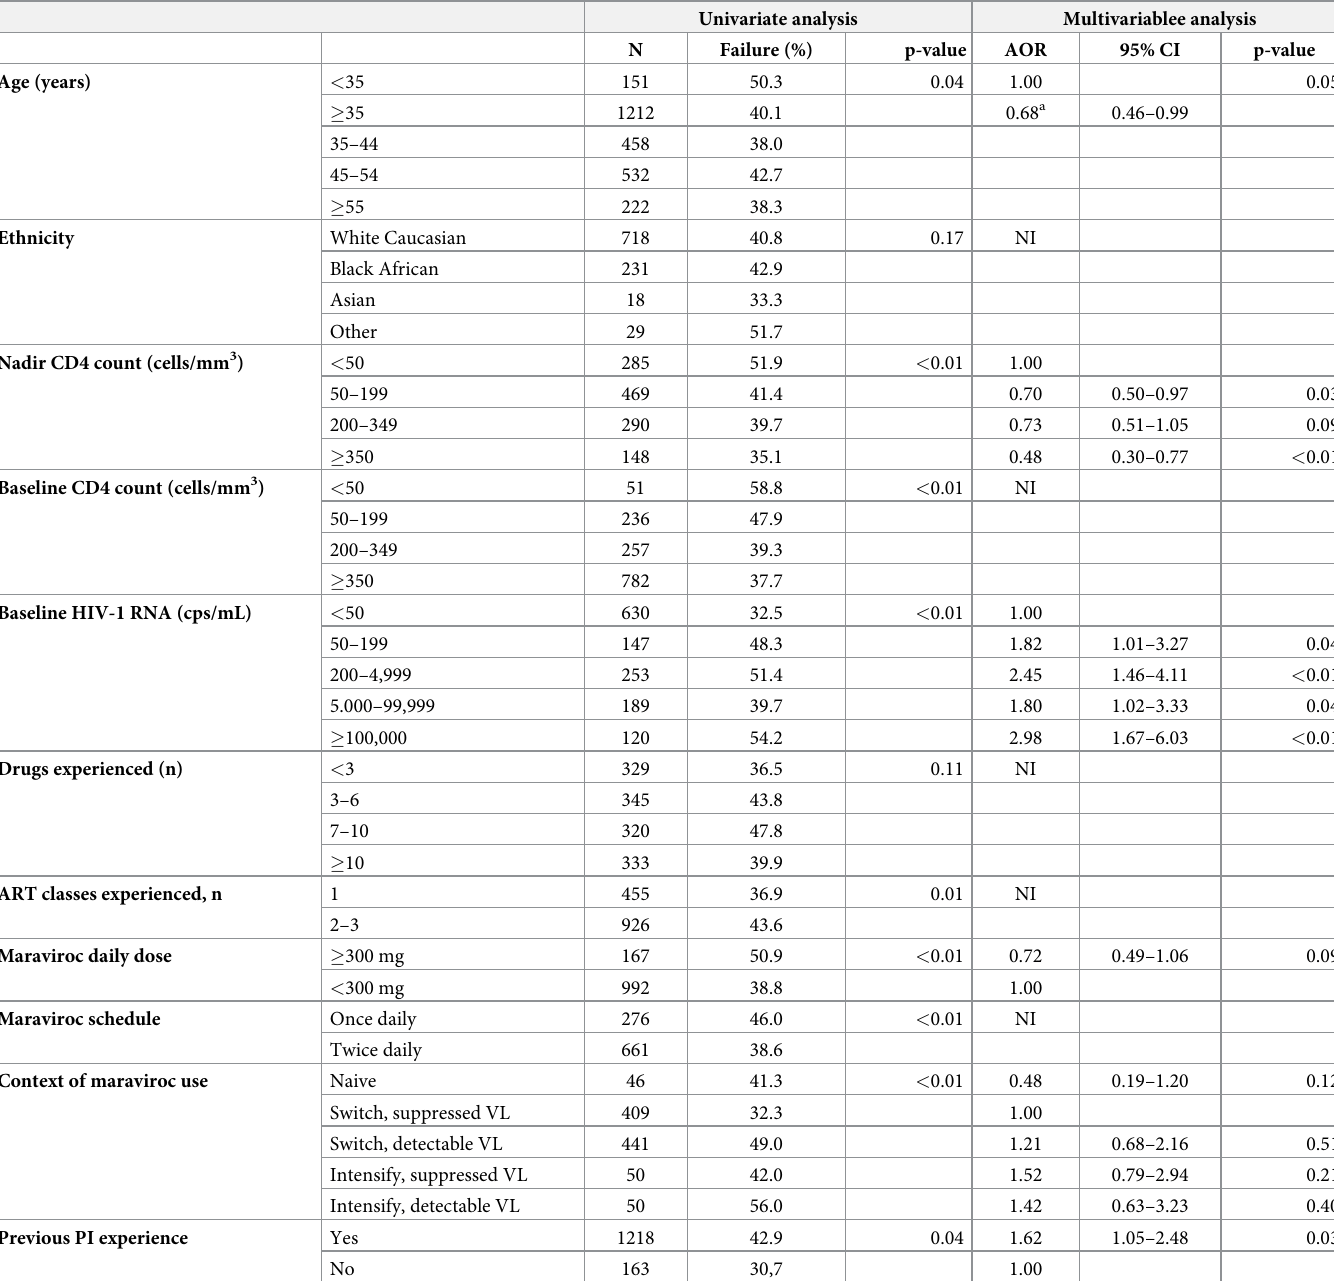
Table 4. Univariate and multivariable logistic regression analysis of factors associated with treatment failure over 48 weeks.